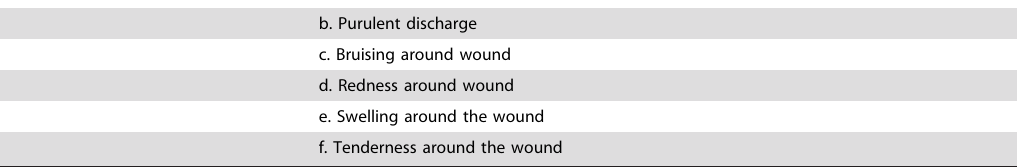
Condition Signs and